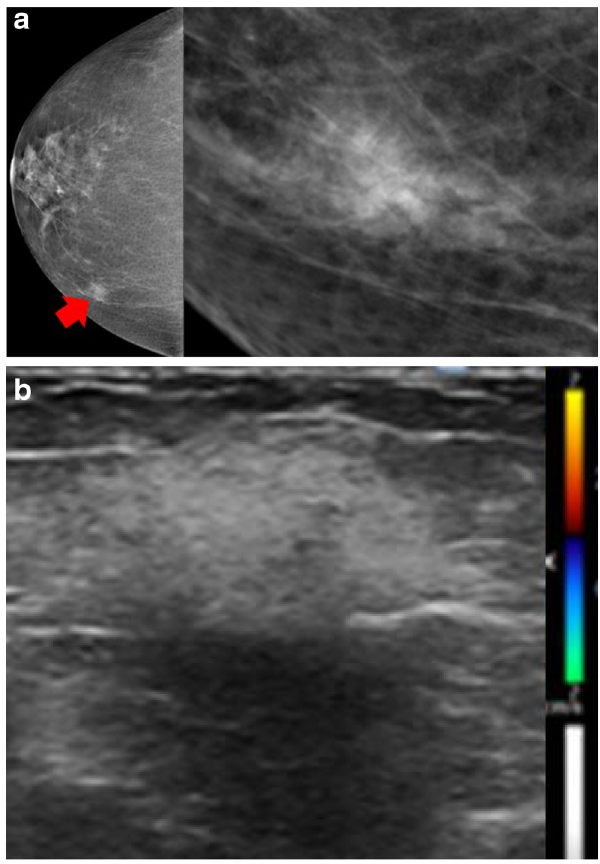
Fig. 6 Autoimmune cause: Sjögren ’ s syndrome. A 61-year-old woman with Sjögren ’ s syndrome was positive for anti-Ro/Sjögren ’ s syndrome antigen A antibody. a Mammographic right craniocaudal with craniocaudal spot compression views showed a mass with ill-defined margins at the 2 o ’ clock position of the right breast ( red arrow ). b Ultrasound of the right breast showed an oval, hyperechoic mass with ill-defined margins, posterior shadowing and absent vascularity. Ultrasound-guided biopsy showed non-necrotising granulomatous in- flammation(notshown). Fungal andacid-fastbacilli stains were negative, and angiotensin-converting enzyme and immunoglobulin G4 levels were normal. The patient received treatment for Sjögren ’ s syndrome, and the mass was no longer present at 6-month follow-up